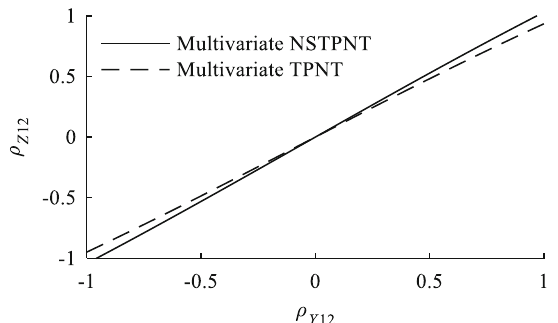
Fig. 5 Comparison of the transformed correlation coefficient